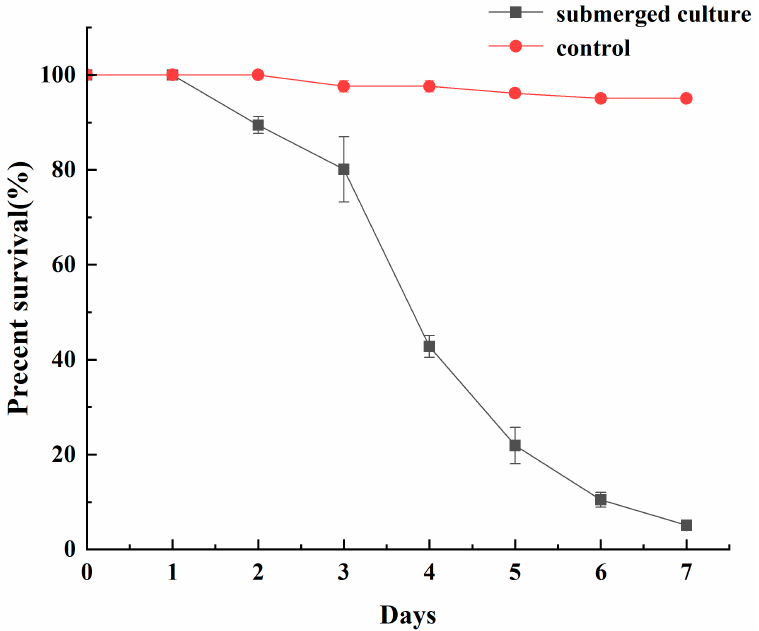
Figure 7. Survival of M. persicae treated with optimized submerged culture for 7 days. The control was sterile water. Submerged culture significantly decreased survival compared to control ( χ 2 = 25.816, df = 1, p < 0.001). The data in the figure are the mean ± SEM. The SEM of three repetitions is shown in bars.